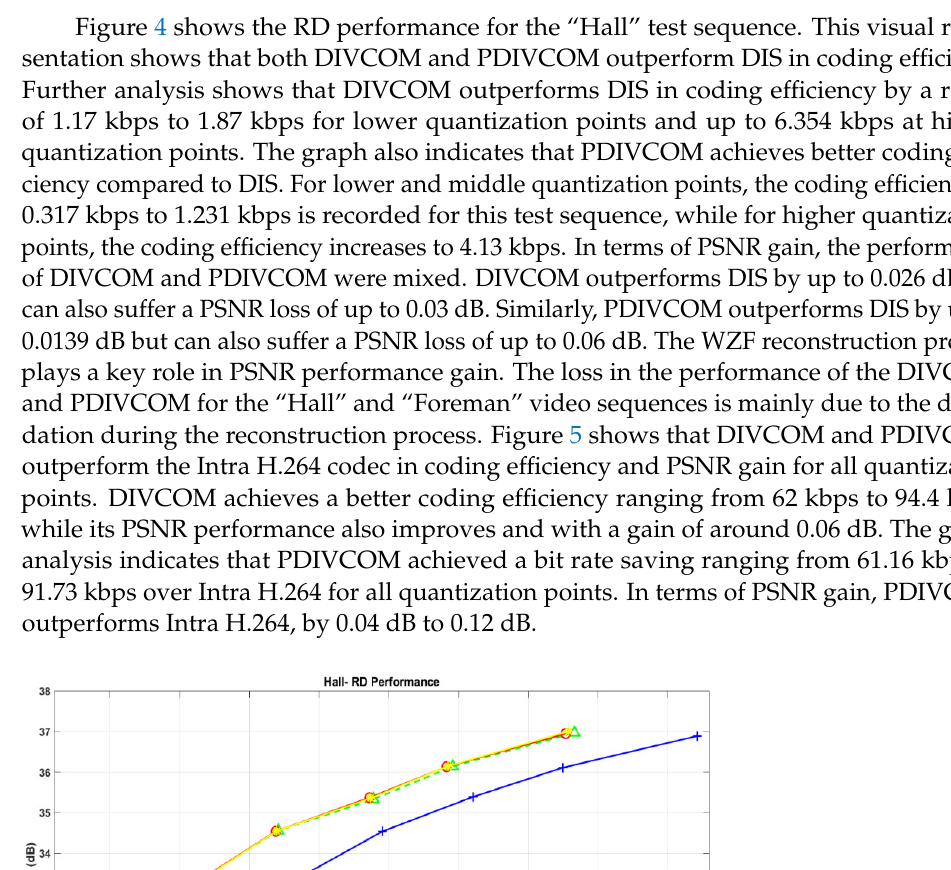
Table 9. Coding efficiency evaluation of proposed novel online CNM for “Hall” video sequence.